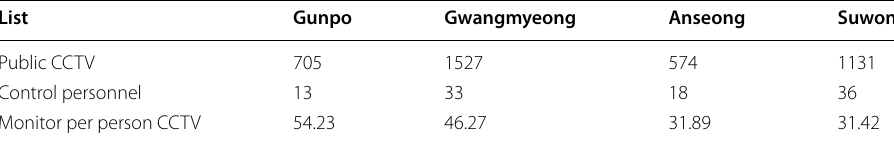
Table 1 Status of public CCTV and control